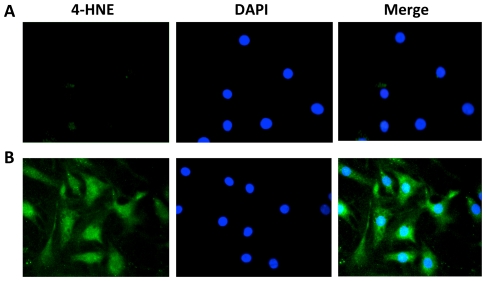
CSE produces 4-HNE in ATI-like cells.A - Control; B - Cells exposed to 5% CSE for 24 h. Cells were probed by 4-HNE primary antibody, stained with Alexa Fluor 488 as secondary antibody (green) and mounted with Vectashield medium containing DAPI (blue). Shown are representative images from three independent experiments.